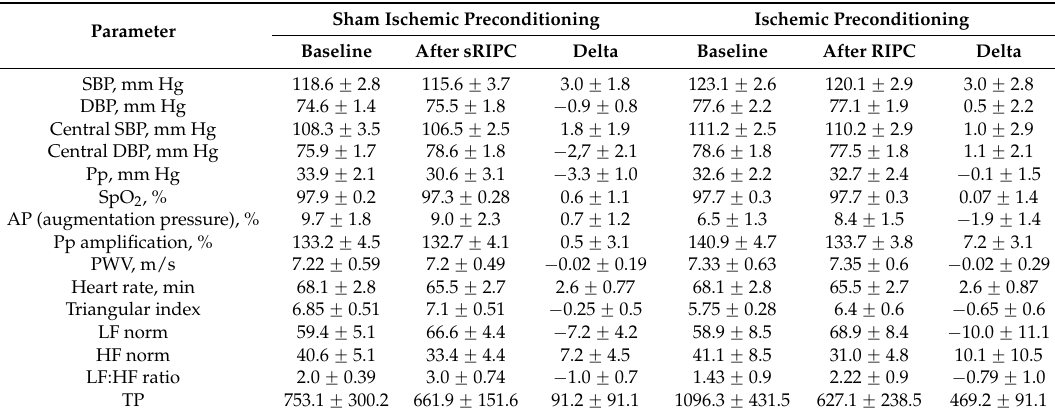
Table 2. Remote ischemic preconditioning (RIPC) and sham RIPC (sRIPC) impact on cardiovascular parameters in control group ( n =